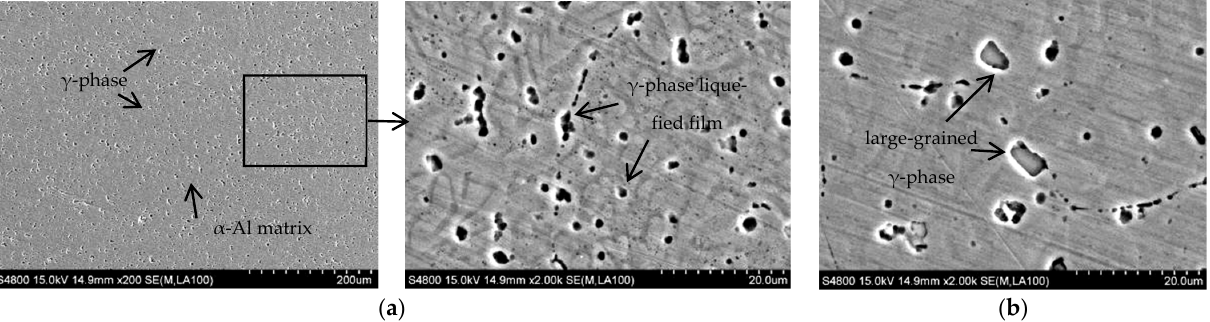
Figure 6. SEM microstructure of Al-Mg alloyed additive under different linear energies: ( a ) 1440 J/cm line energy; ( b ) 1800 J/cm line energy.